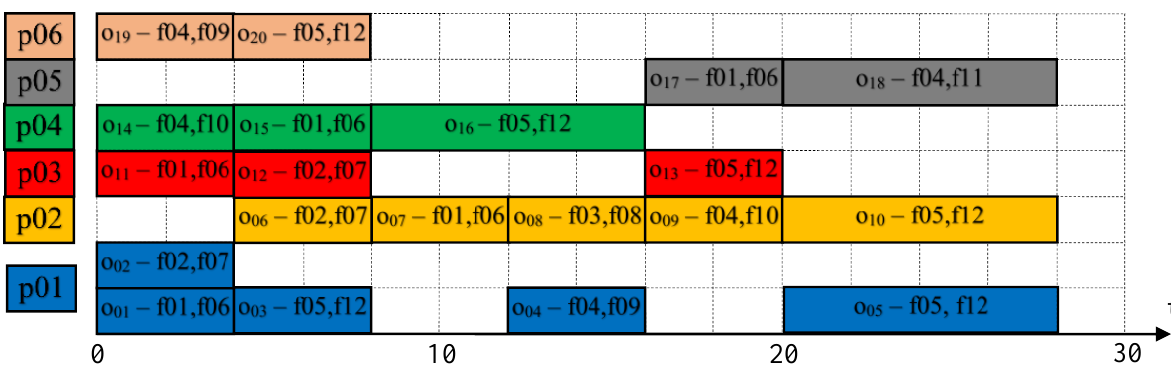
Figure 5. Execution schedule for illustrative example.